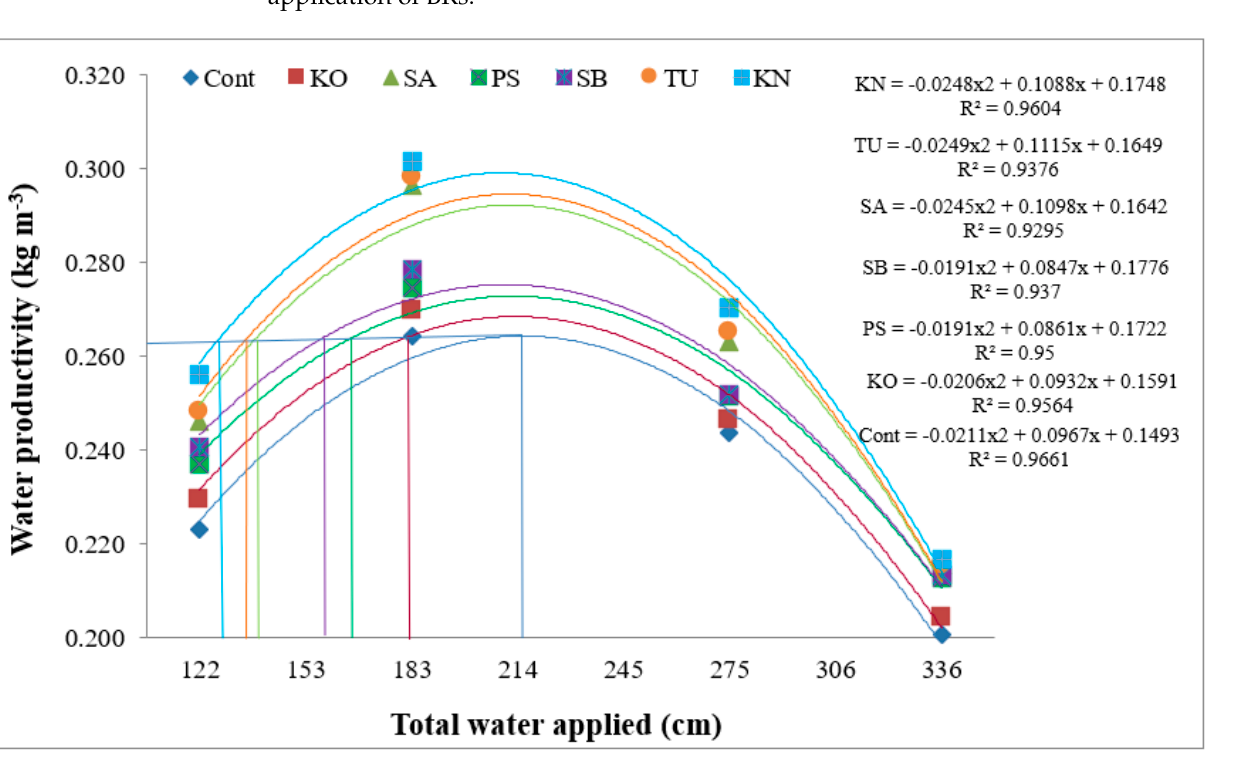
Figure 5. Water productivity functions for chia seed as influenced by bioregulators, viz. cont, KO, PS, SB, SA, TU, and KN. KO—kaolin; KN—potassium nitrate; PS—potassium silicate; SA—salicylic acid; TU—thiourea; SB—sodium benzoate.